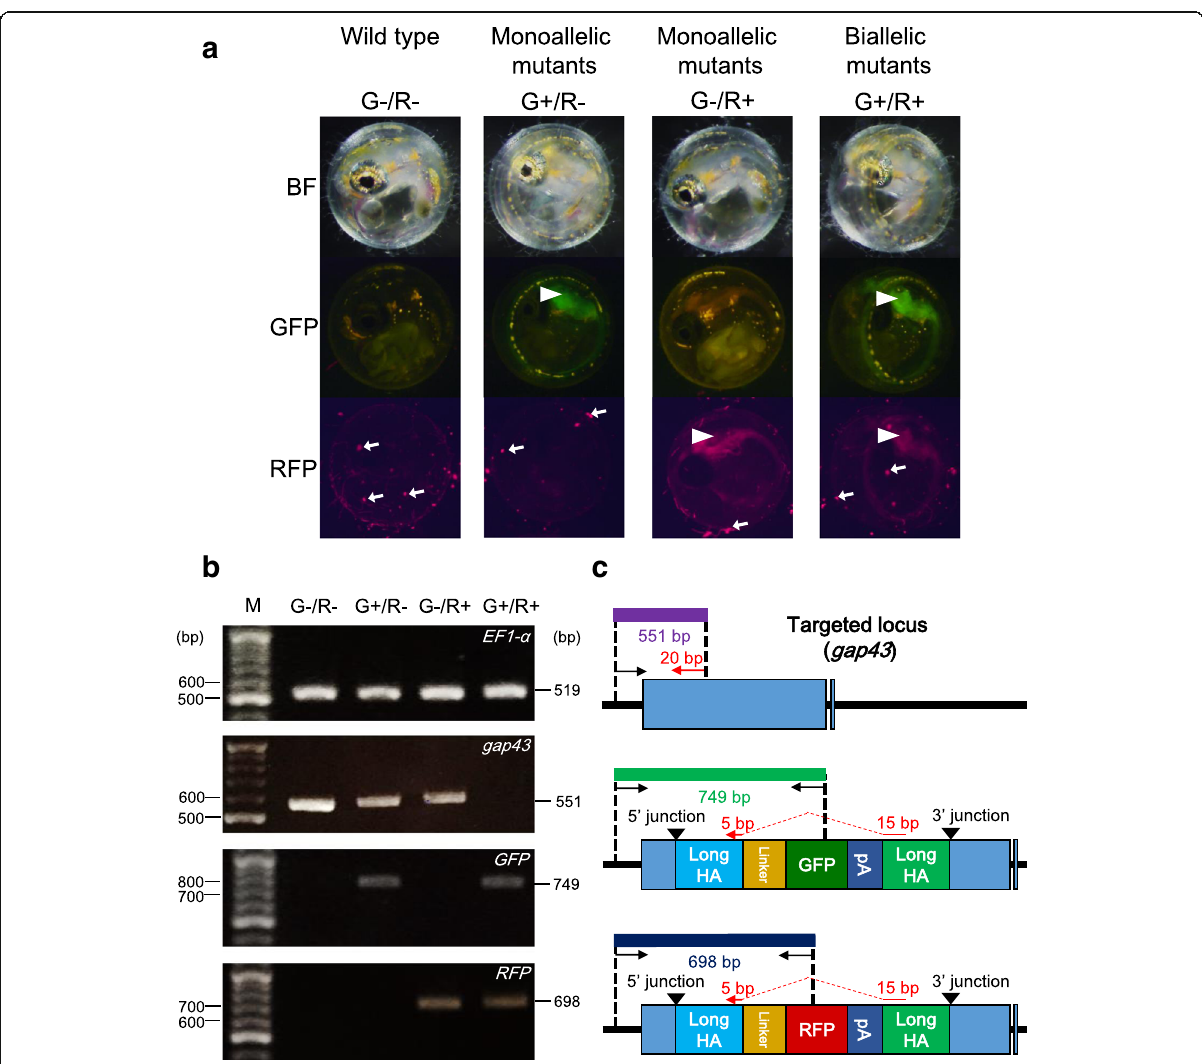
Fig. 5 Selection of biallelic mutants using two different colors of fluorescence. (a) Fluorescence of F 2 embryos derived from mating with each F 1 monoallelic mutants harboring either the GFP or the RFP gene in the gap43 locus. Each of the F 2 embryos were categorized into the following four groups; no fluorescence (G − /R – ), green fluorescence (G+/R – ), red fluorescence (G − /R+), and both green and red fluorescence (G+/R+). The images were captured at 4 days post fertilization (dpf). White arrowheads show fluorescence in the central nervous system (CNS), while white arrows show autofluorescence of bacteria on the surface of the egg membrane. (b, c) PCR genotyping of the F 2 embryos derived from mating between the F 1 monoallelic mutants. (b) The EF1- α fragment (519 bp) was used to confirm genomic DNA extraction, and was detected in all samples. The gap43 fragment (551 bp) was detected from the groups (G − /R – ), (G+/R – ), and (G − /R+). The GFP fragment (749 bp) was detected from (G+/R – ) and (G+/R+) groups, while the RFP fragment (698 bp) was detected from (G − /R+) and (G+/R+) groups. In (G+/R+), no PCR product of gap43 was detected. (c) Design of PCR primers to detect the targeted gene integration into the gap43 locus. (Upper): Genomic structure of the intact gap43 locus. The size of the PCR product amplified using primer pair (GAP43-for-Seq-Fw and GAP43-Rv) is 551 bp. The latter primer is 20 bp in size and is shown as a red arrow. The reverse primer is designed on the boundary between upstream and downstream long homology arms, so that this primer pairs can amplify the intact locus but not the GFP- or RFP-integrated loci. (Middle): Genomic structure of gap43 locus at which the donor plasmid harboring the GFP gene is integrated. The size of the PCR product amplified using the primer pair (GAP43-for-Seq-Fw and mAG-Rv) is 749 bp. (Lower): Genomic structure of the gap43 gene at which the donor plasmid harboring the RFP gene is integrated. The size of the PCR product amplified using the primer pair (GAP43-for-Seq-Fw and tdTomato-Rv) is 698